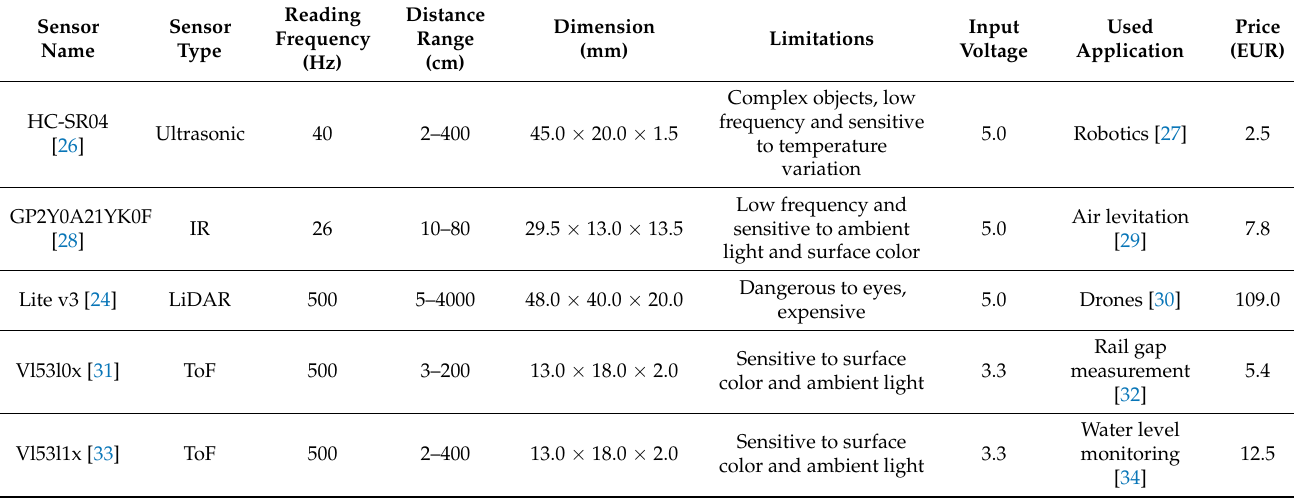
Table 1. Specifications of different distance